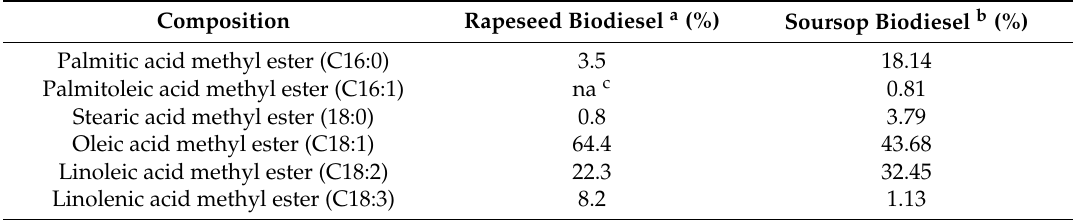
Table 2. Fatty acid methyl ester compositions of soursop biodiesel compared with rapeseed biodiesel. Composition Rapeseed Biodiesel a (%) Soursop Biodiesel b (%) Palmitic acid methyl ester